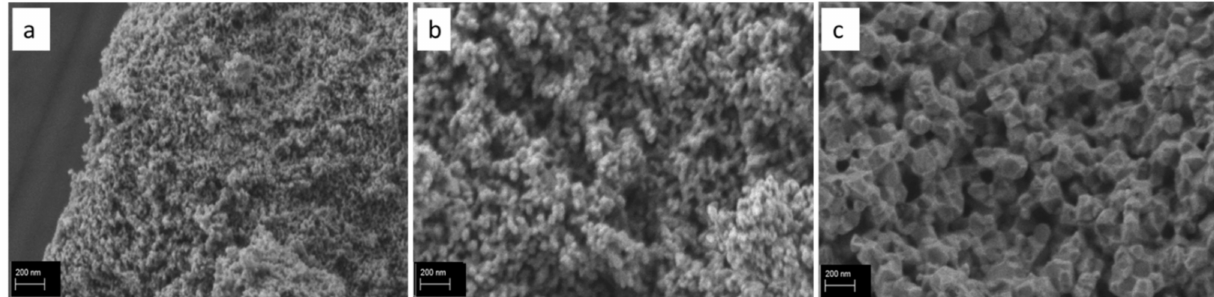
Figure 3. SEM images of the nY-ZrO powders sintered at 800 (( a )-nY-ZrO800), 1000 (( b )-nY-ZrO1000) and 1200 ◦ C (( c )-nY- ZrO1200), showing increase in crystalline size with increase in sintering temperature.